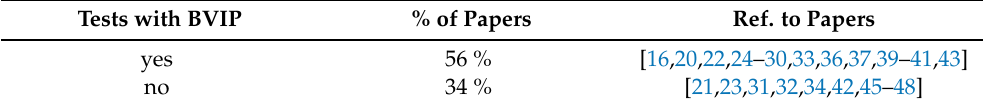
Table 13. Tests with BVIP or not (in general blindfolded people). Tests with BVIP